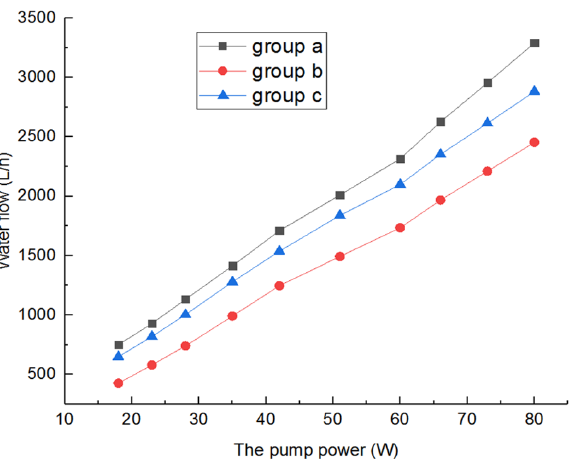
Figure 11. Water pump at different powers flowing through the three water ‐ cooled plate and the flow rate size relationship.